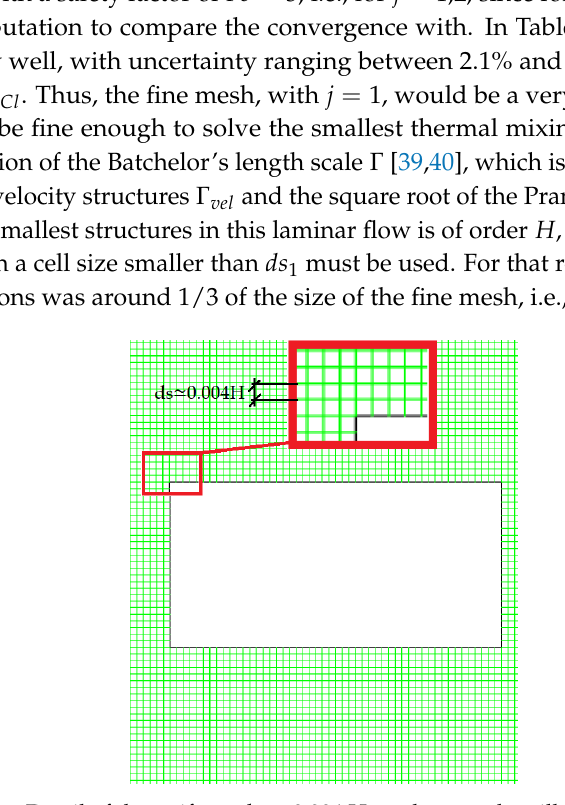
Figure 3. Detail of the uniform ds (cid:39) 0.004 H mesh around a pillar with AR =